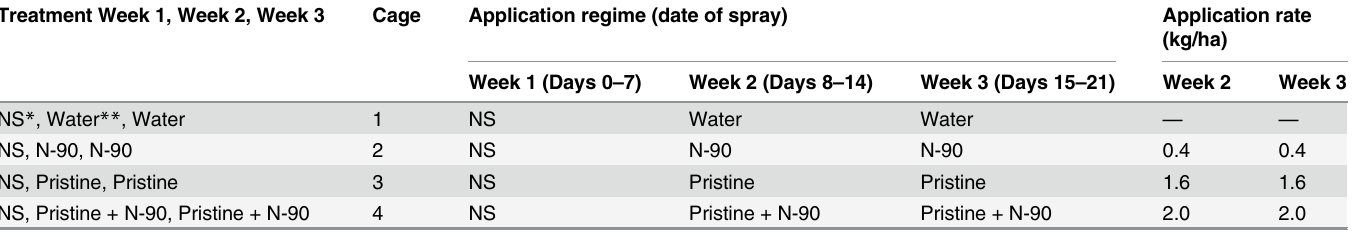
Table 2. Fungicides and adjuvant spray treatments and application rates applied weekly on planted fields of Phacelia tanacetifolia in screened field cages where 20 uniquely paint-marked Megachile rotundata females were nesting. Treatment sprays occurred on the evening of days 7 (July 5) and 14 (July 12) when bees were not active. The cage experiment was conducted at in North Logan, Utah in